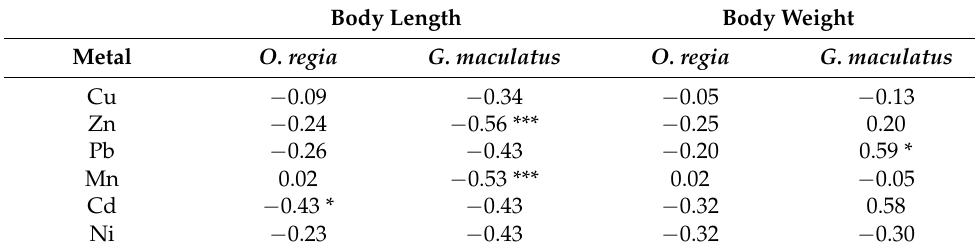
Table 3. Pearson correlation levels and significance between heavy metals from tissue, and body size variables (Length and weight) of Odontesthes regia and Galaxias maculatus individuals from the Valdivia River estuary. Statistically significant values for pairwise comparisons are denoted by * < 0.05, *** < 0.001. Body Length Body Weight O.